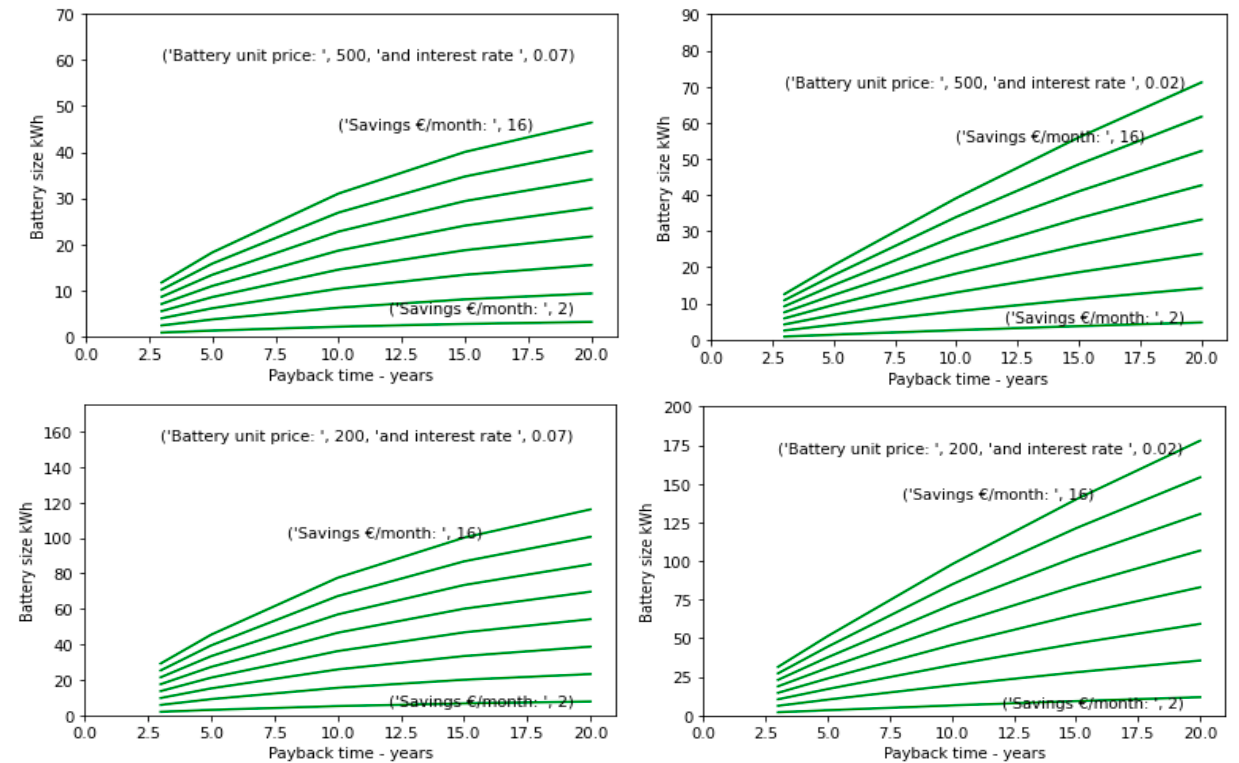
Figure 6. Different investment scenarios showing what battery capacity can be expected dependent on interest rates, payback time and potential savings in power tariffs due to curtailment. Upper plots: battery unit price of to €500 per kWh and interest of, respectively, 7% and 2%. Lower plots: battery unit price of to €200 per kWh and interest of, respectively, 7% and 2%.